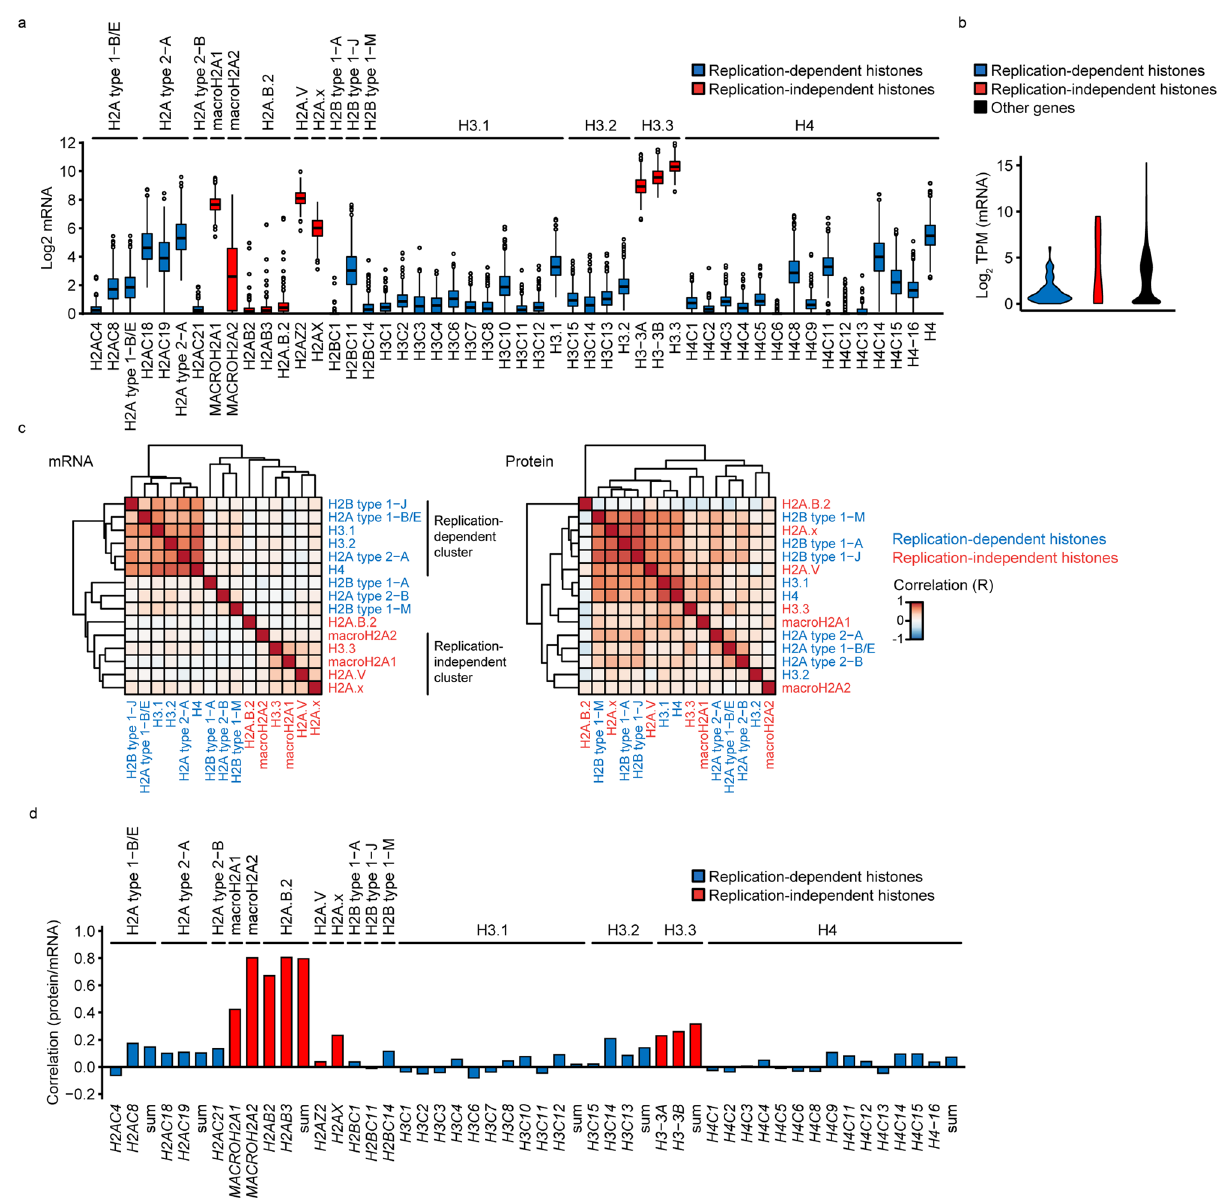
Fig. 1 Histone mRNA and protein expression in CCLE datasets. a , b Histone mRNA levels in cancer cell lines. a The boxplots show the histone mRNA read distribution across cancer cell lines from the CCLE expression (RNA-Seq) dataset for which proteome data are available. Histone gene names are speci fi ed by x axis labels. Histone genes are grouped by the encoded histone variant as indicated above the boxplots. The x label sum indicates that the boxplot represents the read sum of all detected histone transcripts encoding the respective variant. b Mean read counts of replication-dependent and -independent histone genes were calculated for each CCLE cell line. The violin plots display their distribution across cell lines. The colors represent the histone classi fi cation by replication dependence. c Correlation of histone mRNAs and proteins across cancer cell lines. The heatmaps represent Pearson correlation coef fi cients of estimated histone mRNA variant levels and histone protein variant levels from the CCLE RNA-Seq expression and proteomics datasets, organized by hierarchical clustering. Font colors indicate histone classi fi cation by replication dependence. d Correlation of histone proteins vs. mRNAs across cancer cell lines. The barplots represent Pearson correlation coef fi cients of histone protein variants vs. the encoding mRNAs. Axis labels and color coding are as in ( a ). Cell lines covered by both CCLE RNA-Seq and proteomics datasets ( N = 372) are represented. Only histone genes are represented of which the encoded protein variant is covered by the proteomics datasets. Data in ( c , d ) were lineage-centered. TPM transcripts per